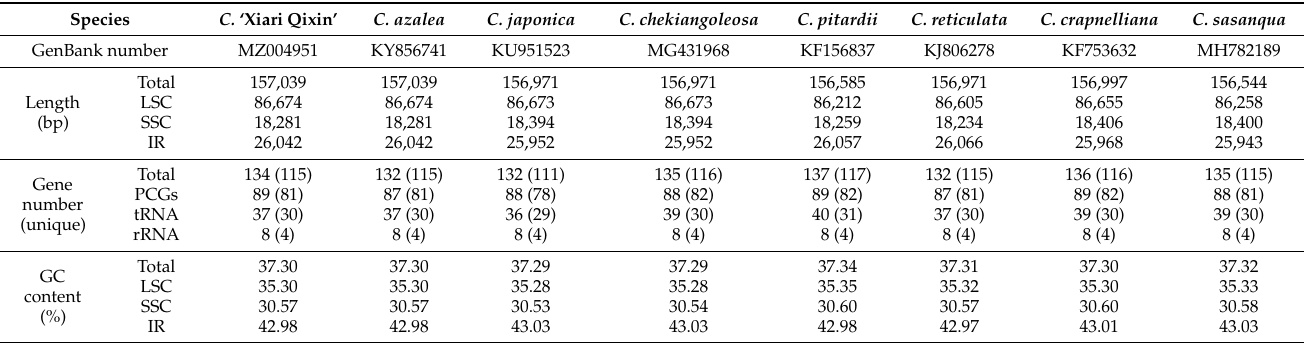
Figure 1. Gene map of chloroplast genome for Camellia ‘Xiari Qixin’. The innermost track of dark gray represents GC contents; genes shown on the outside of the map are transcribed in a clockwise direction, while genes on the inside of the map are transcribed in a counterclockwise direction; LSC, large single copy region; SSC, small single copy region; IRA/B, inverted repeat A/B region. Table 1. The features of chloroplast genomes for C. ‘Xiari Qixin’ and seven Camellia